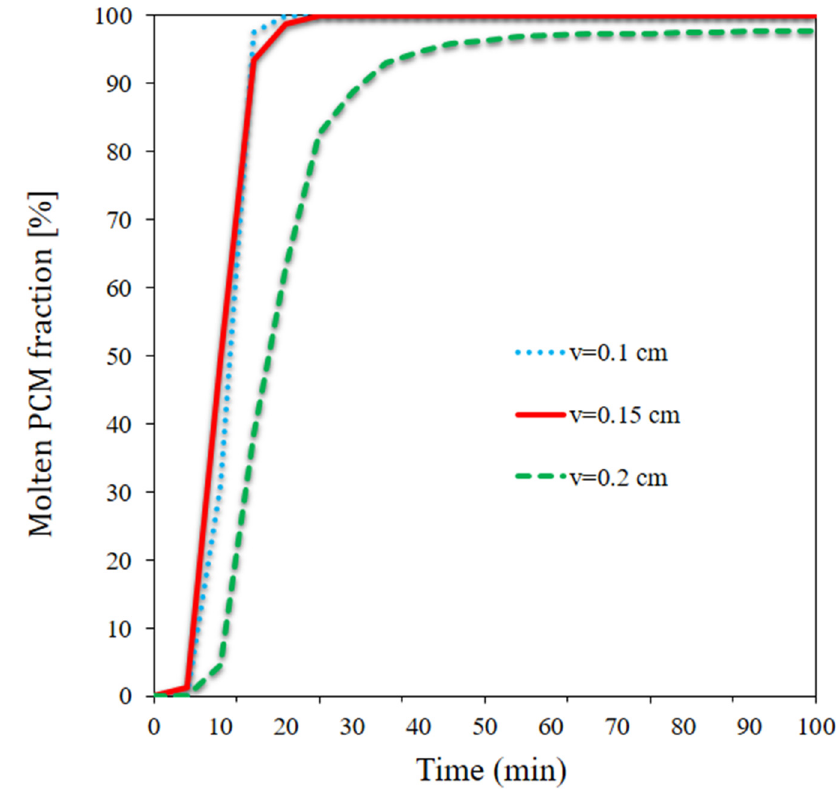
Figure 12. The melted PCM volume fraction for three velocities over time.